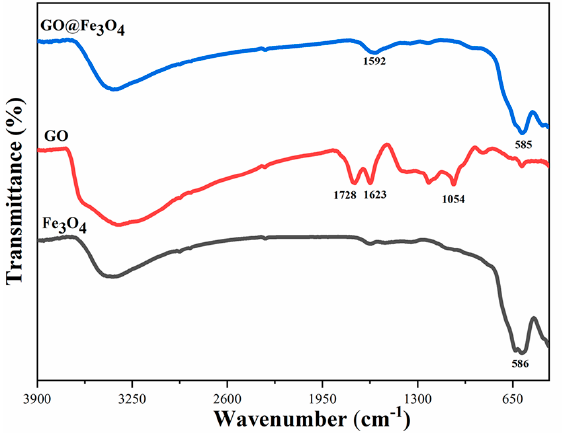
Figure 5. FT - IR patterns of Fe 3 O 4 , GO and GO@Fe 3 O 4 . Figure 5. FT-IR patterns of Fe 3 O 4 , GO and GO@Fe 3 O 4